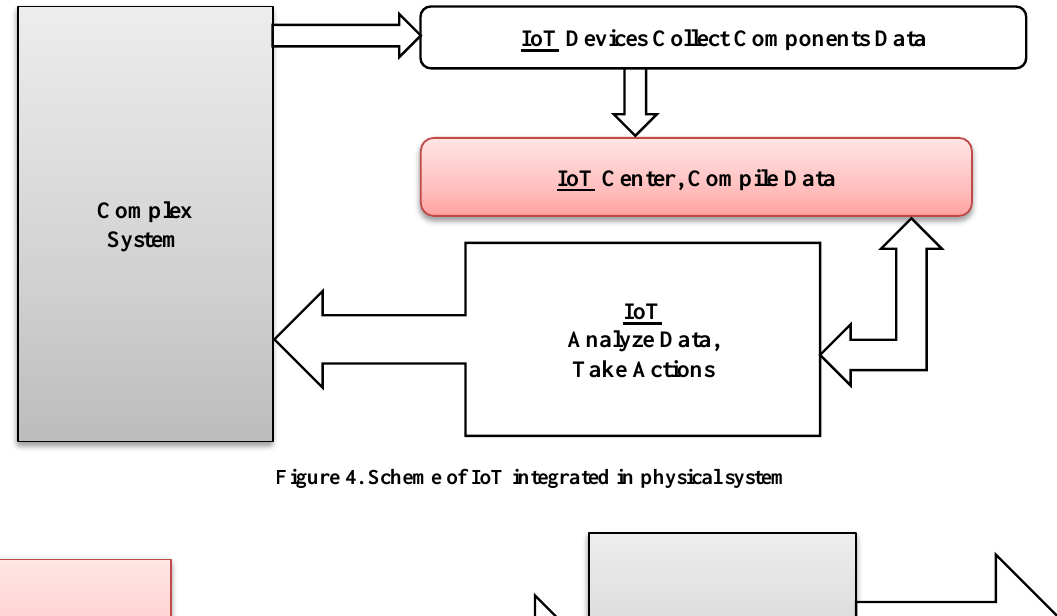
Figure 4. Scheme of IoT integrated in physical system